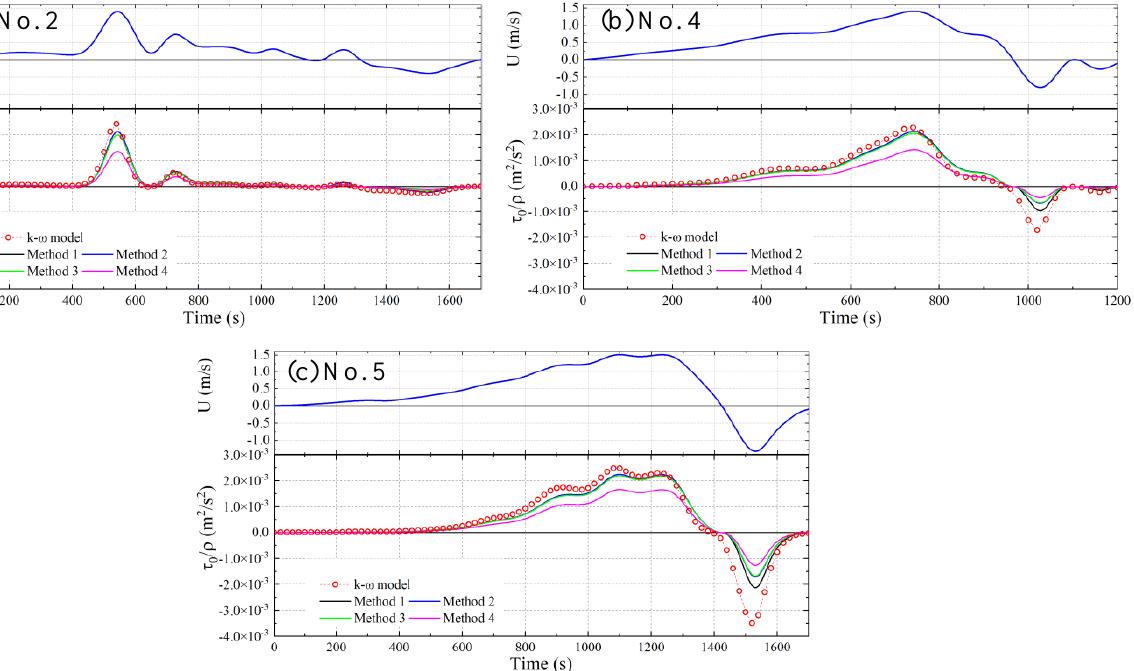
Figure 12. Flow velocity and bottom shear stress at the measuring point ( a ) No. 2, ( b ) No. 4, and ( c ) No. 5.